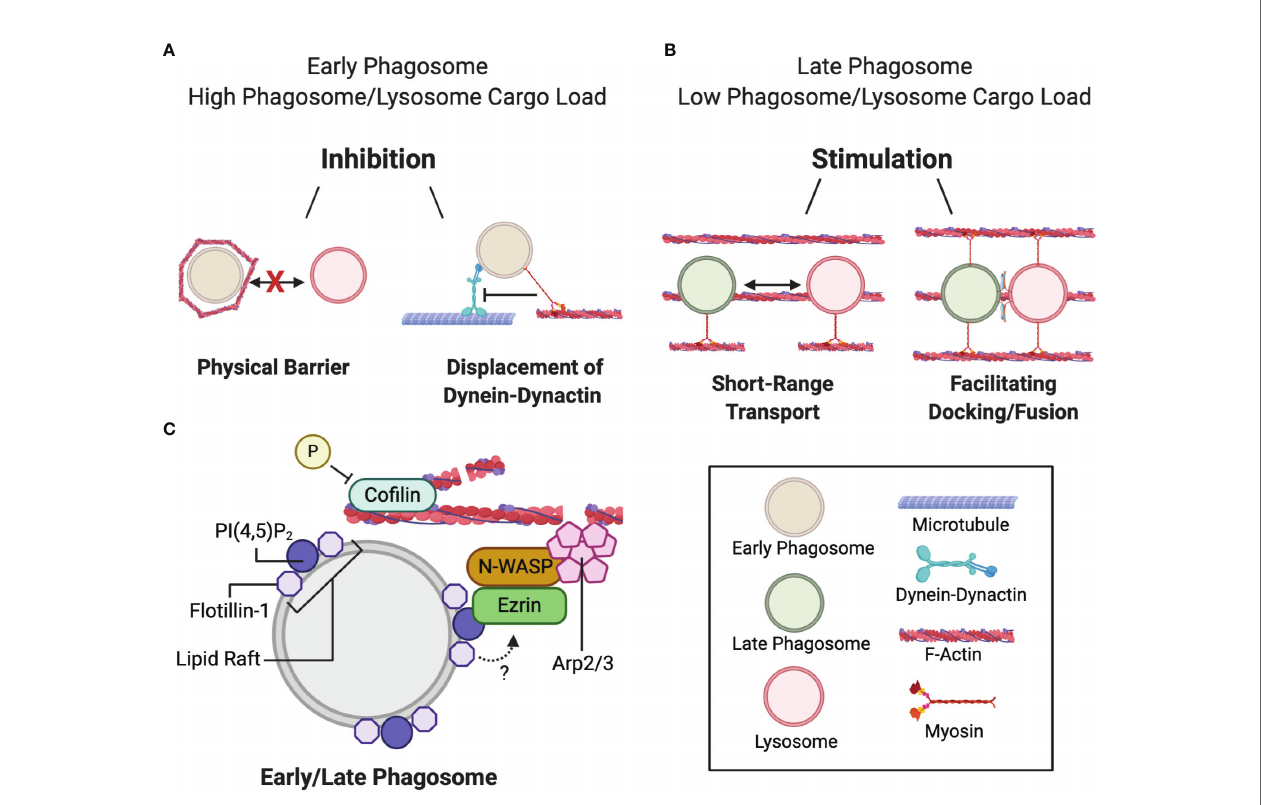
FIGURE 3 | Duality of fi lamentous actin during phagosome maturation. (A) Actin delays phagolysosome biogenesis at the early phagosome maturation stage by: i) transiently assembling around nascent phagosomes when the early phagosome and/or lysosome system is overloaded with cargo thereby blocking phagosome- lysosome contact, or ii) by facilitating myosin-mediated displacement of the dynein-dynactin microtubule motor and preventing minus-end transport. (B) Actin stimulates phagolysosome biogenesis by: i) bringing the fusing organelles closer together, or ii) facilitating docking and fusion. (C) Actin polymerization at the phagosome is mediated by the ezrin-N-WASP-Arp2/3 complex binding to phagosomal PI(4,5)P 2 at fl otillin-1-associated lipid rafts. Cyclic actin polymerization and depolymerization is mediated by the respective phosphorylation and dephosphorylation of co fi